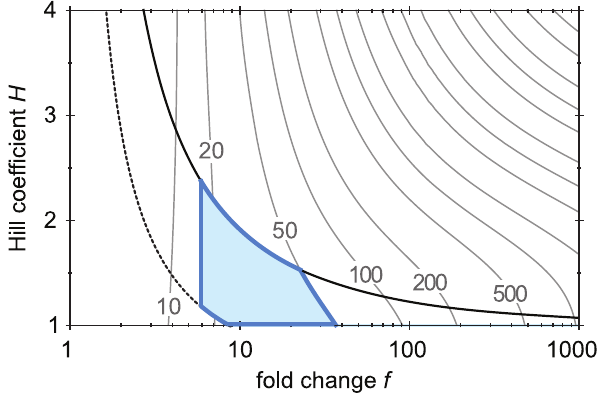
Figure 5. Summary of results. Only in the shaded area is the circuit mono-stable, sensitive ( s d w 2 ), reasonably fast (induction time v 50 min ), with a non-negligible fold-change ( f w 6 ). Of course, the precise borders of the area depend on the stringency of the circuit’s functional requirements. Based on these results, inducible auto- activation circuits should have an at most moderate fold change; also, a modest Hill coefficient between 1 and 2 is sufficient. This can be achieved by auto-activation mediated by a single TF